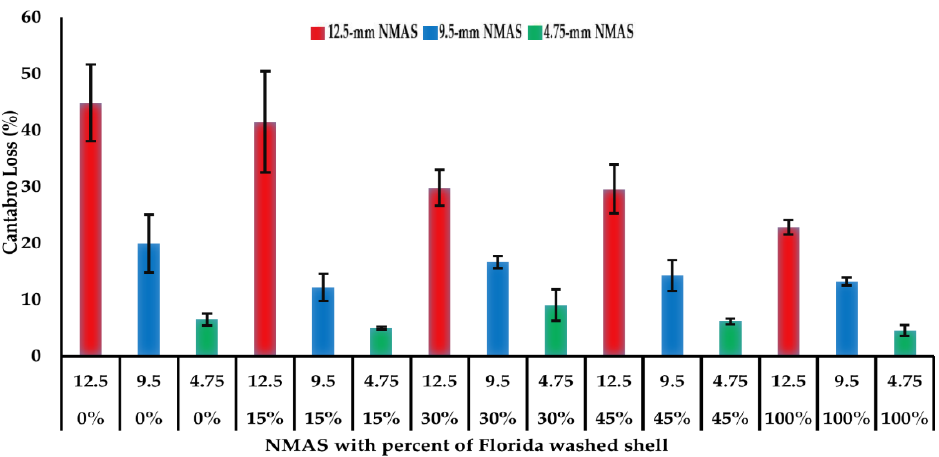
Figure 4. Cantabro loss results of open-graded asphalt mixtures.